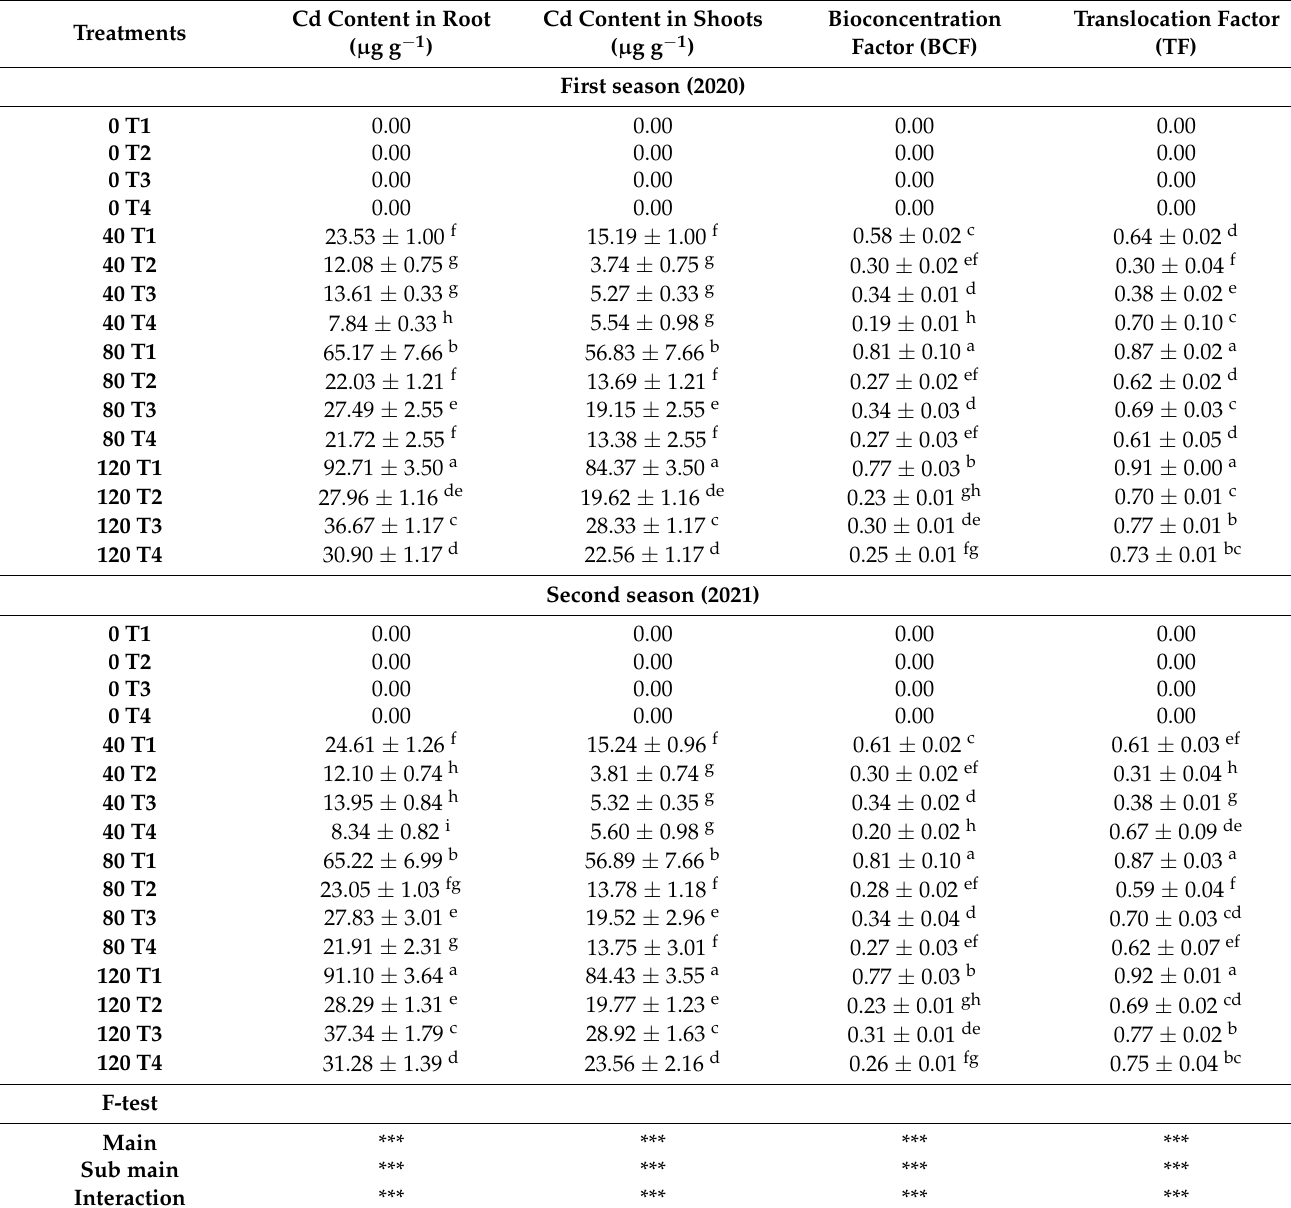
Table 4. Combined effects of different concentrations of Cd and soil amendments on the content of Cd in the roots and shoots, bioconcentration, and translocation factors in lettuce plants 70 days after transplanting during the 2020 and 2021 seasons.